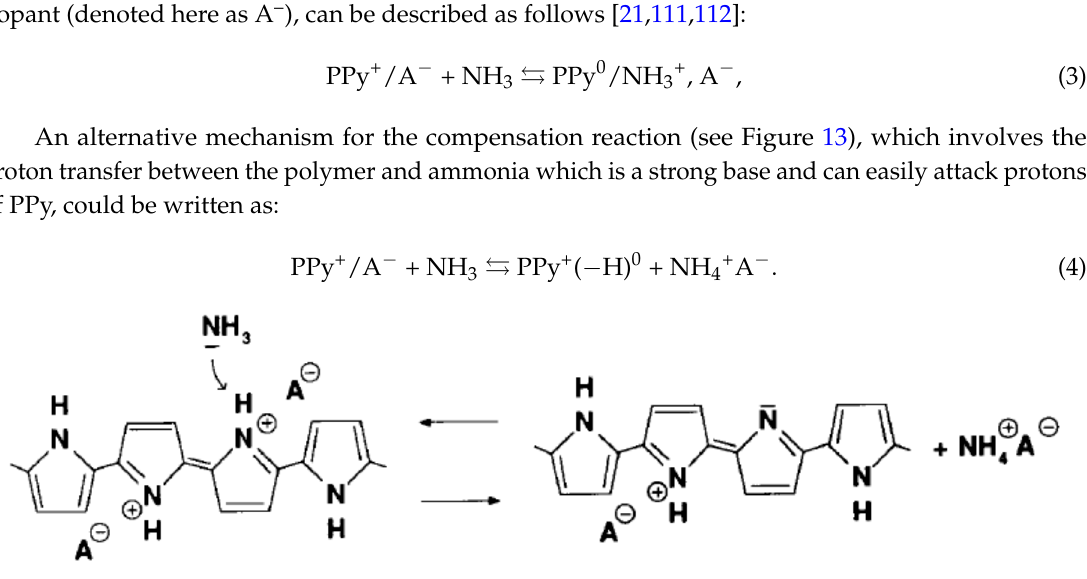
Figure 13. The schematic illustration of PPy interaction with ammonia. Reprinted from [111] with permission from Elsevier. Copyright 2017.